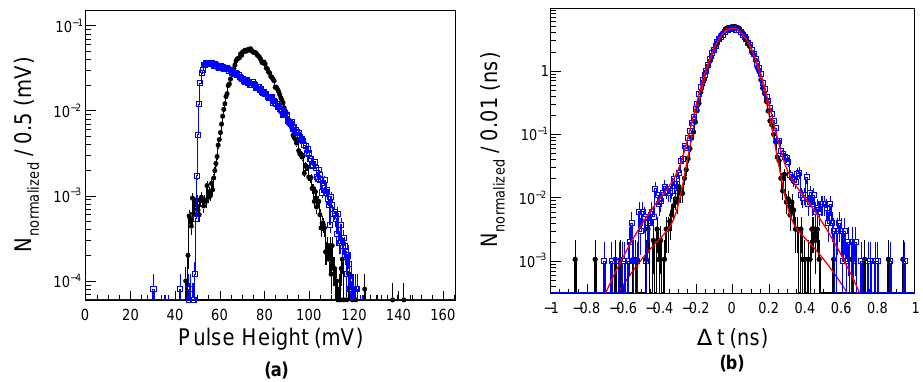
Figure 13. Comparison of the normalized signal pulse heights ( a ) and CTRs ( b ) between exter- nal (filled black circle) and internal (open blue square) trigger modes. The mean amplitude of pulse height is ( 75.2 ± 8.6 ) mV and ( 68.7 ± 12.9 ) mV for external and internal trigger modes, respectively. The CTR represents the core standard deviation of the Gaussian function and reveals ( 78.7 ± 0.3 ) ps and ( 83.3 ± 0.3 ) ps for external and internal trigger modes, respectively.